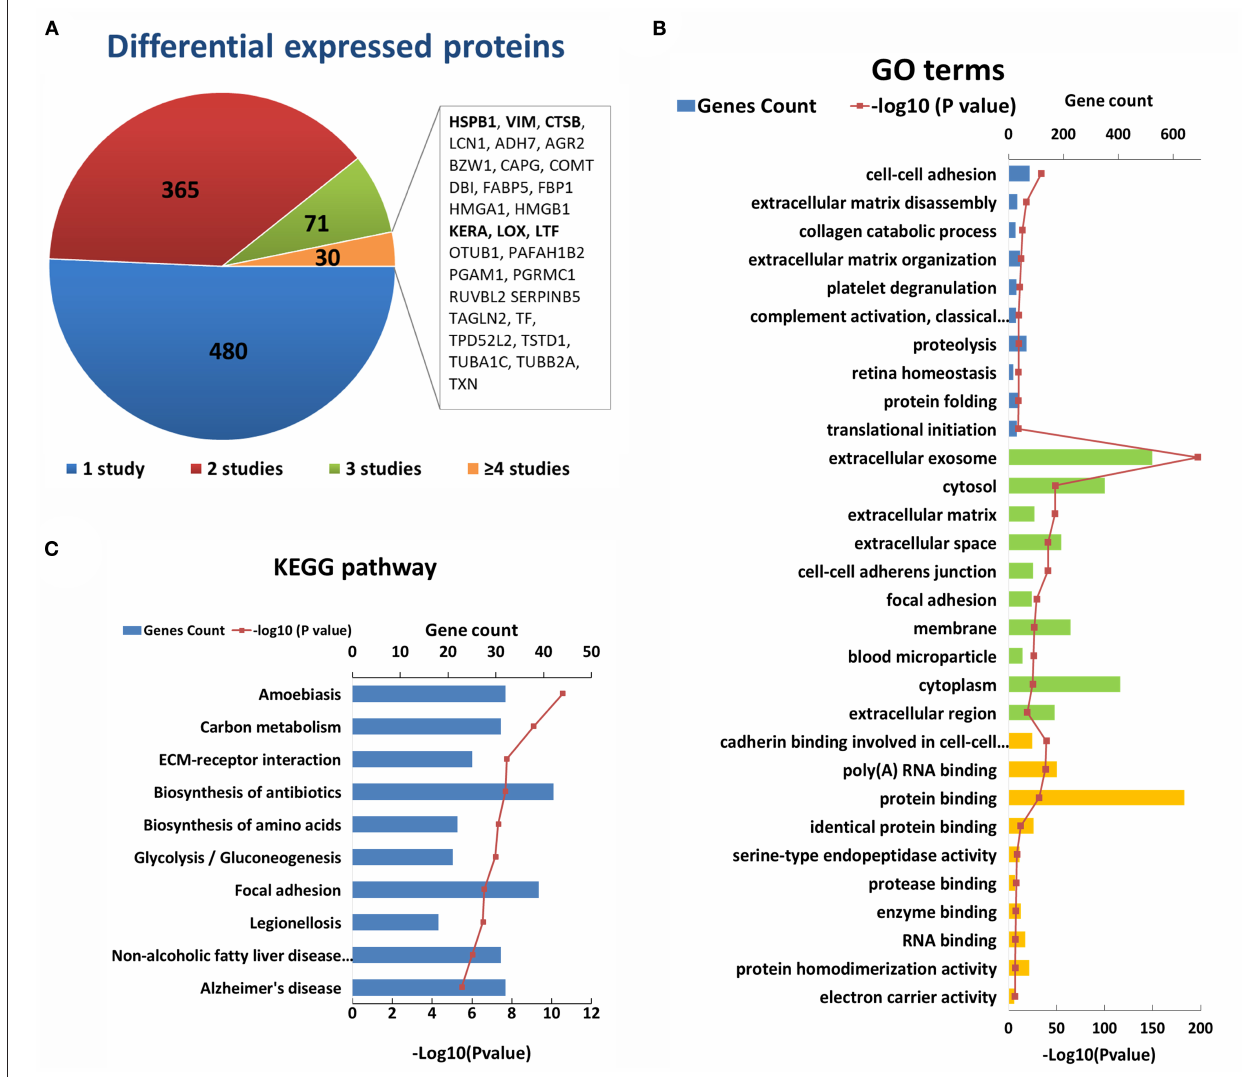
FIGURE 3 | Enriched GO terms and KEGG pathways based on 947 differential genes at the protein level. (A) The classification of the 947 differential proteins according to the number and results of related studies. (B) Top 10 enriched terms of each GO category at the protein level. The three colors represent biological process (blue), cell component (green), and molecular function (yellow), respectively. (C) Top ten enriched KEGG pathways at the protein